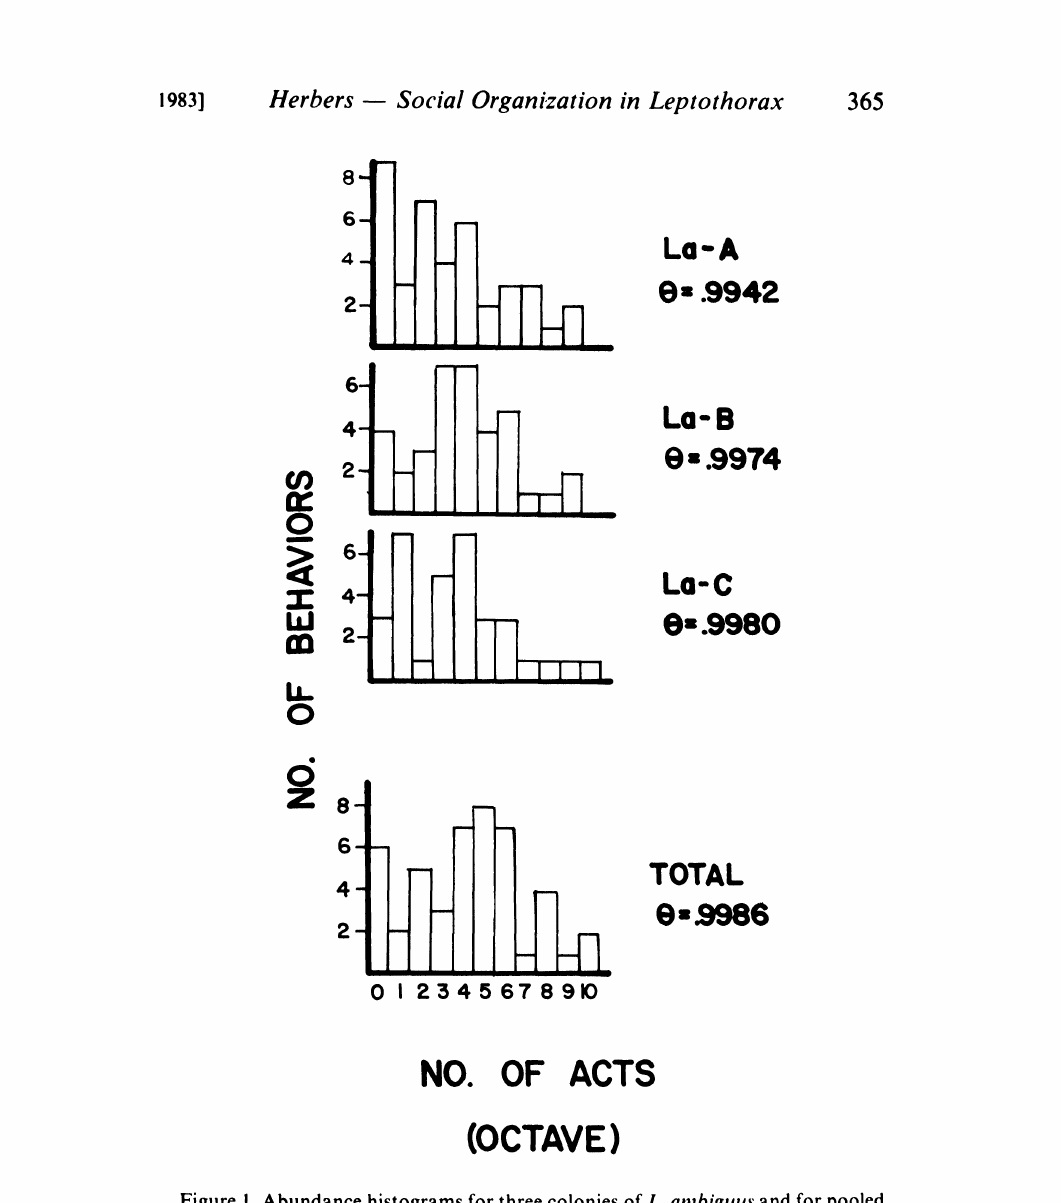
Figure I. Abundance histograms for three colonies of L. amhiguus and for pooled data. The abscissa gives the number of observations per behavior, to the base 2; thus octave 0 indicates behaviors observed once, octave refers to exactly 2 observations, octave 2:3 or 4 observations, octave 3:5 through 8, and so on. The largest octave, 10 refers to behaviors observed 513-1024 times. The value of 0 given for each data set in- dicates the sample coverage, as described by Fagen and Goldman